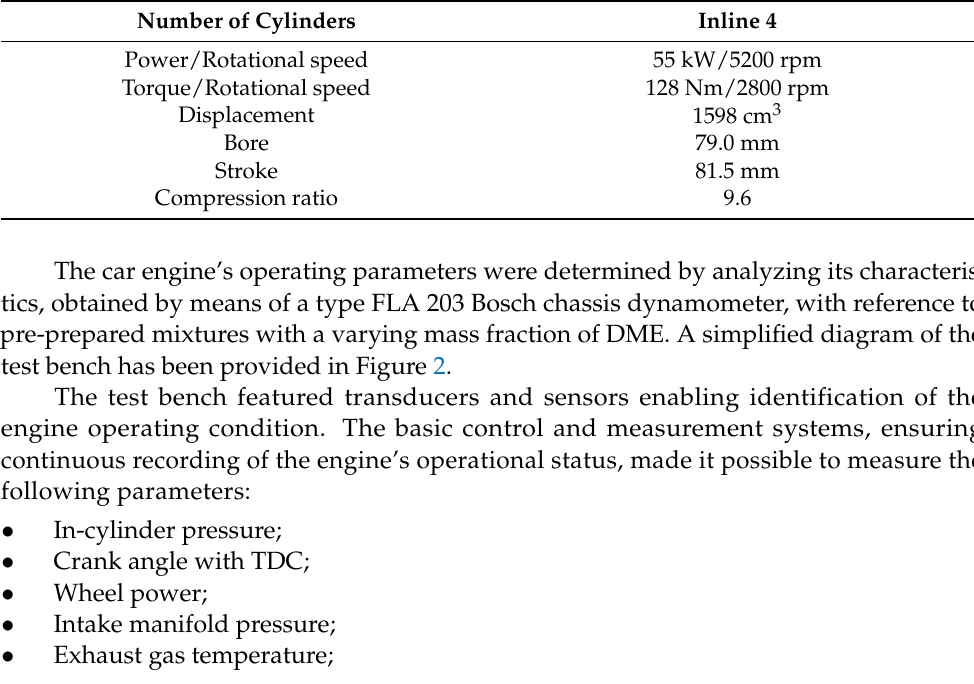
Table 2. Characteristics of the test engine.